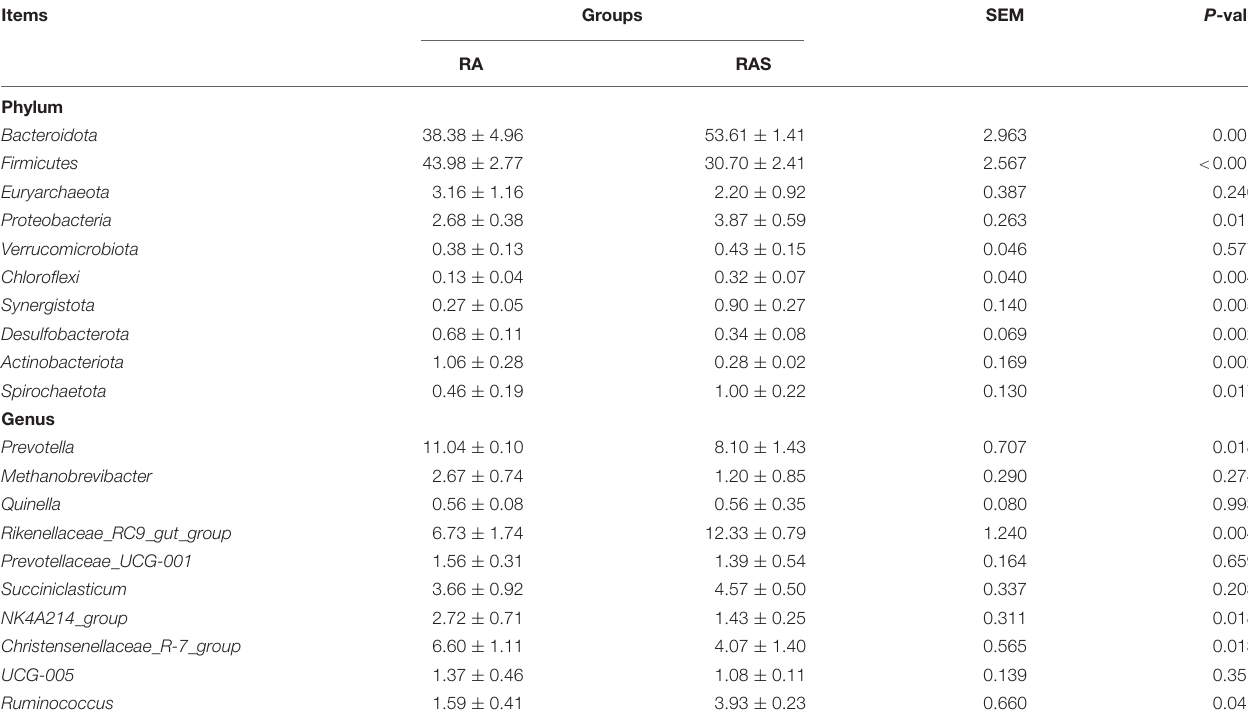
TABLE 5 | Ruminal microbiota community difference between the two groups by using the Mann–Whitney U test. Items Groups SEM P